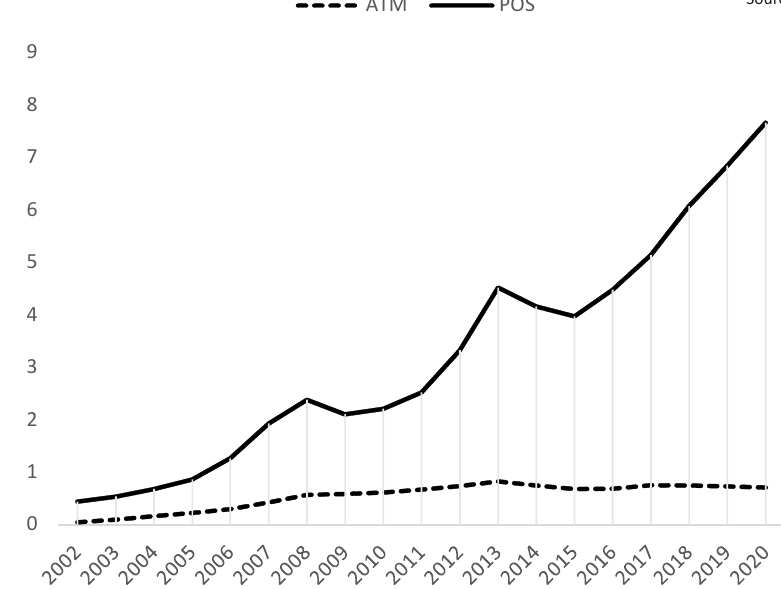
Figure 1. Number of ATMs and POS terminals per 1,000